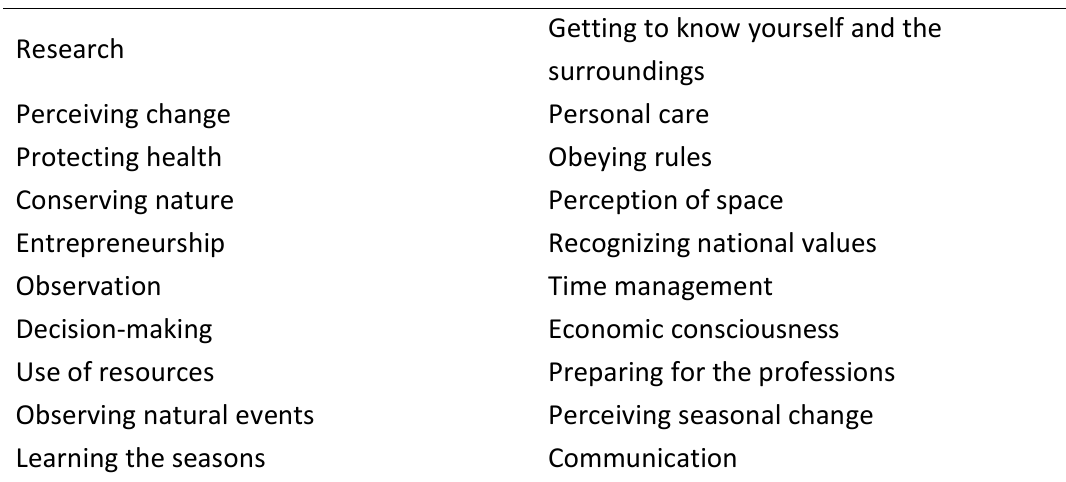
Table 6. Skills in the Life Studies